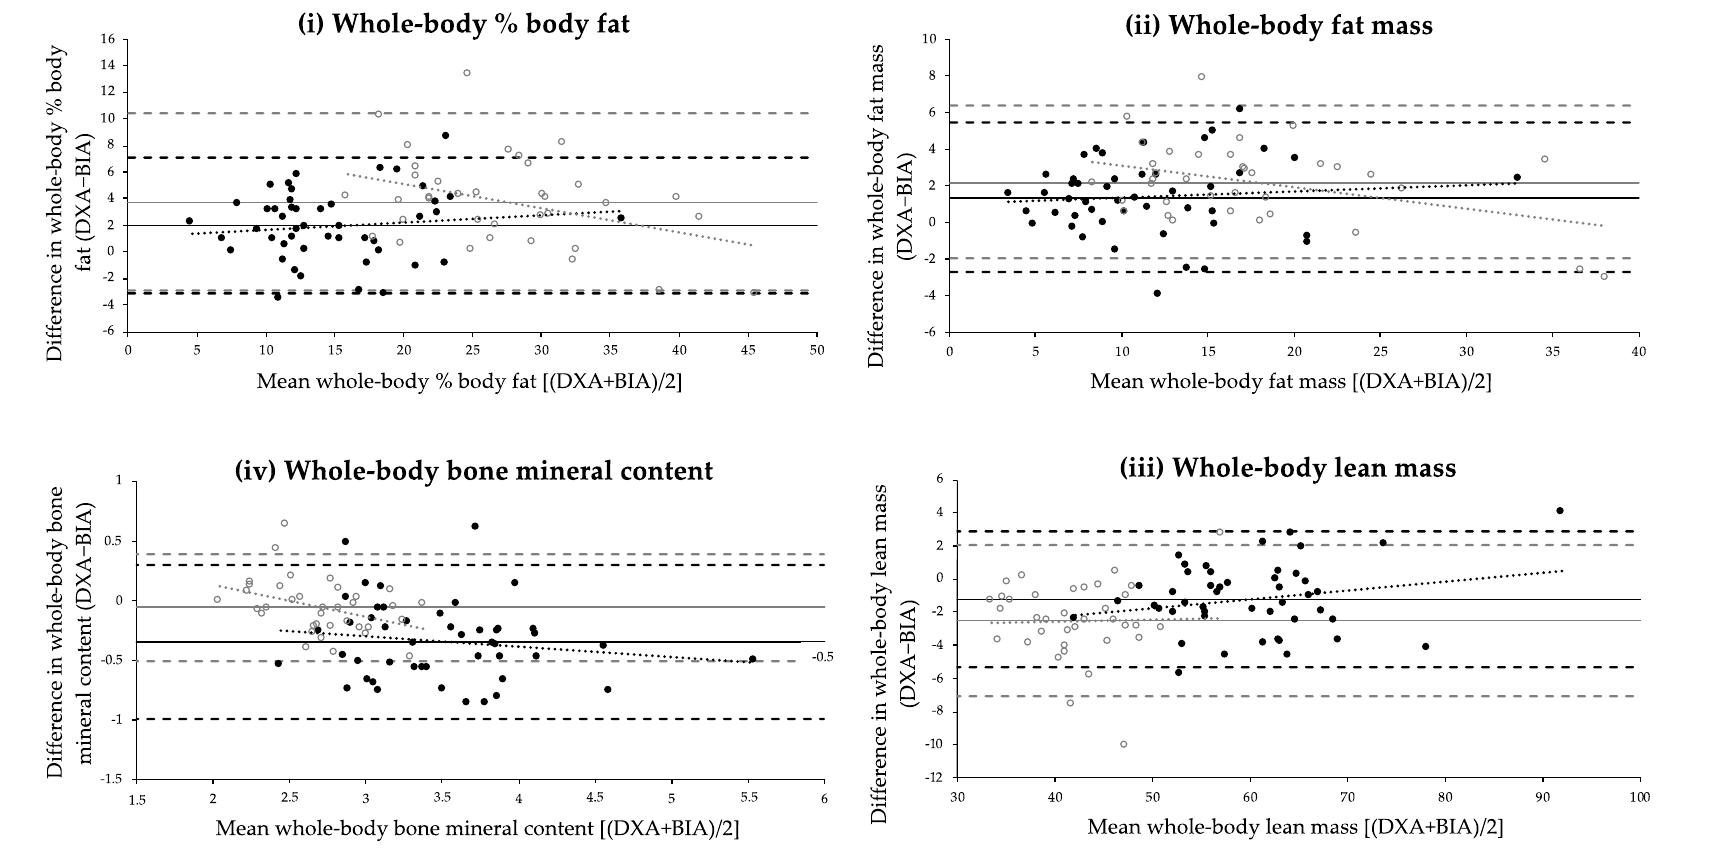
Figure 1. Bland–Altman plots showing the mean value plotted against the mean difference (DXA vs. BIA) for whole-body outcome measures.